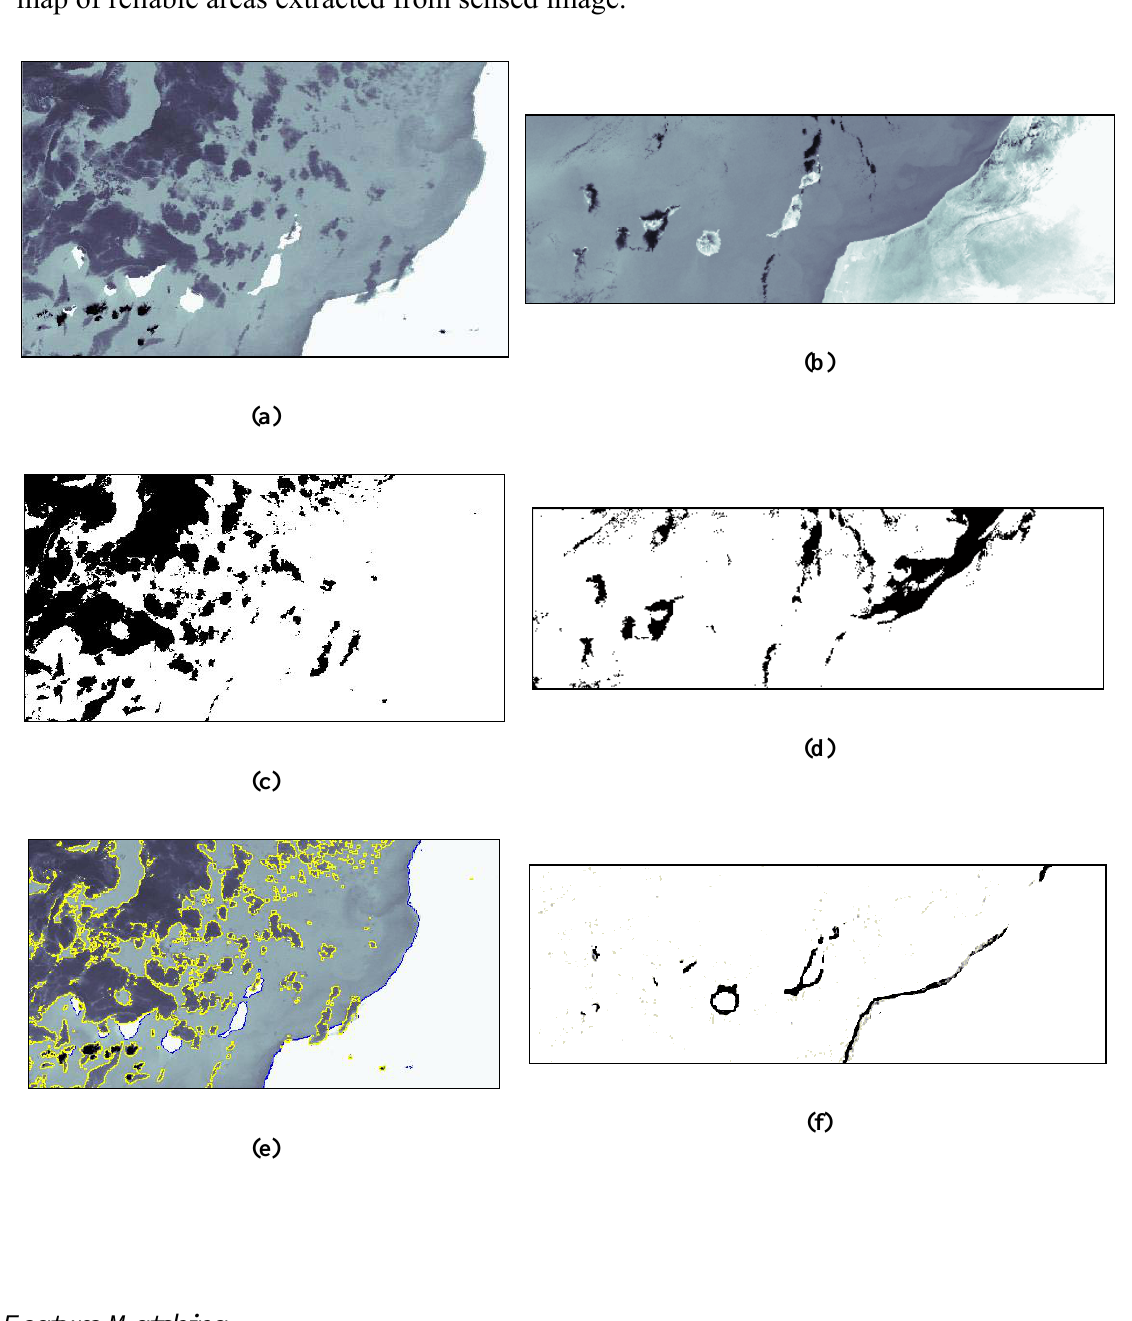
Figure 3. (a), (b) Multitemporal NOAA-AVHRR images; (c), (d) cloud overlays; (e) coastline extracted from reference image (blue contour) and, (f) smoothed gradient energy map of reliable areas extracted from sensed